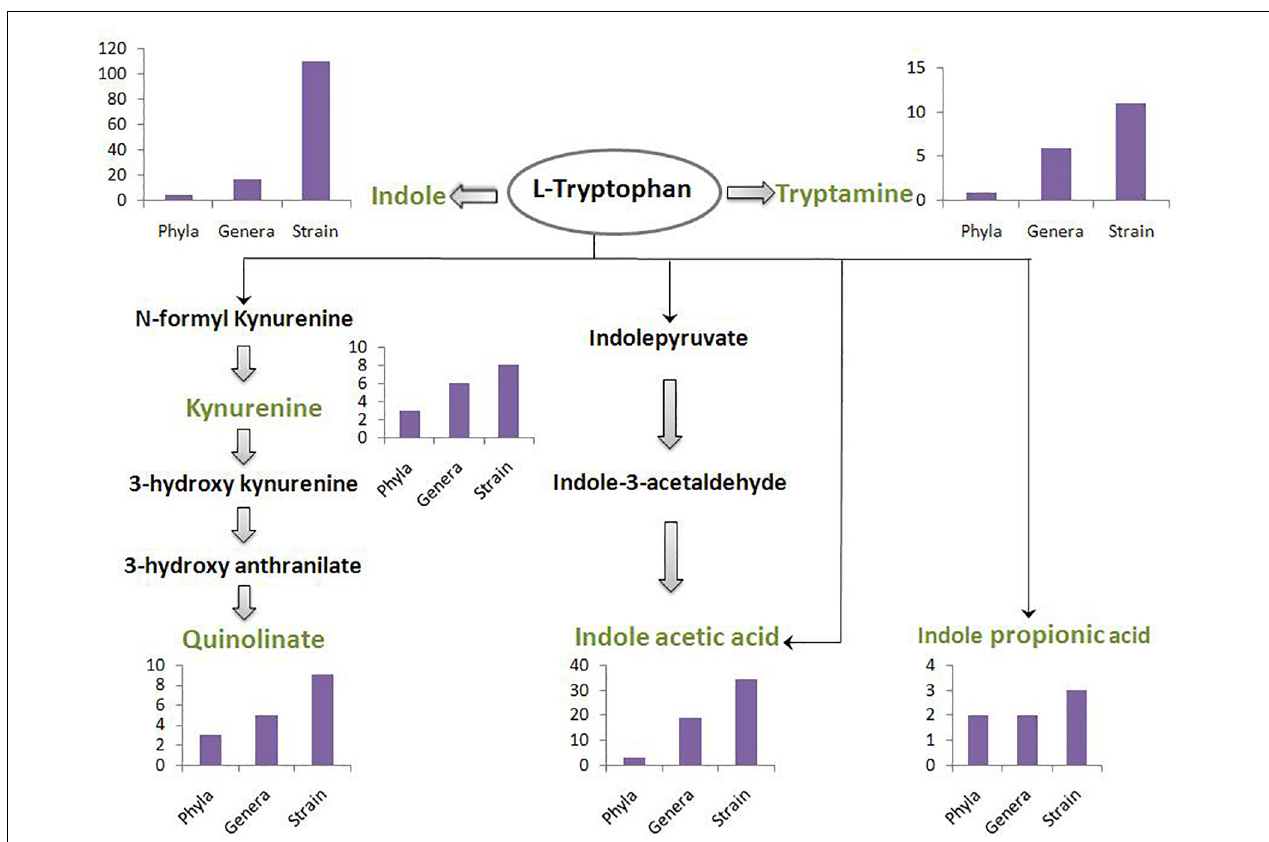
FIGURE 3 | The count of gut bacteria at phyla, genera, and strain levels predicted to possess each of the six analyzed pathways. The pathways pertain to metabolism of tryptophan (indicated in black font inside an oval) for production of six neuro-active compounds namely, indole, tryptamine, kynurenine, quinolinate, indole acetic acid, and indole propionic acid. These six compounds have been indicated in green font. The intermediate compounds of the pathways have been represented in black font. The bar plot depicting phyla-count, genera-count and strain-count for each pathway has been placed behind or below the corresponding neuro-active